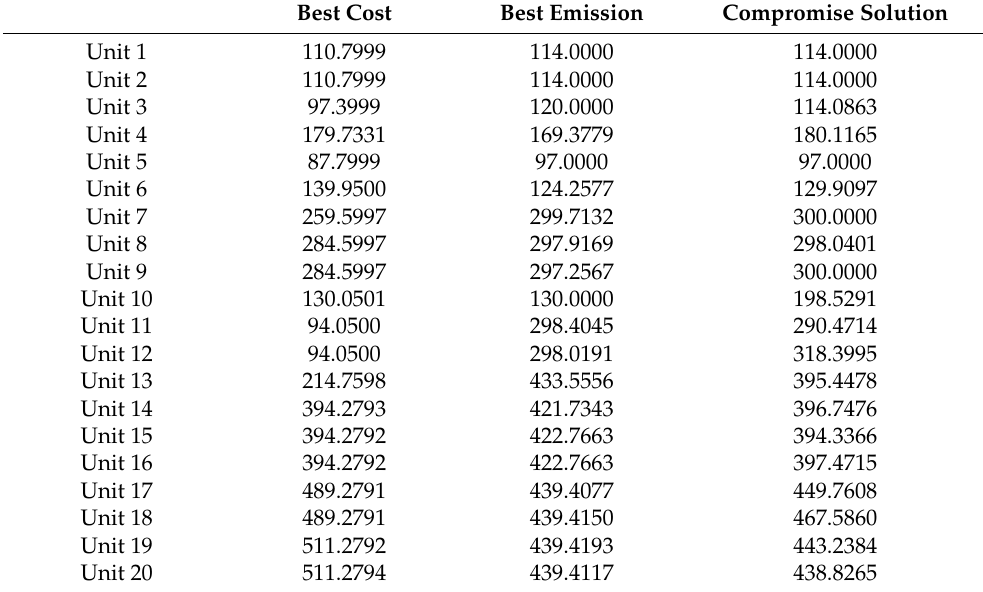
Table 4. Optimum solutions for case